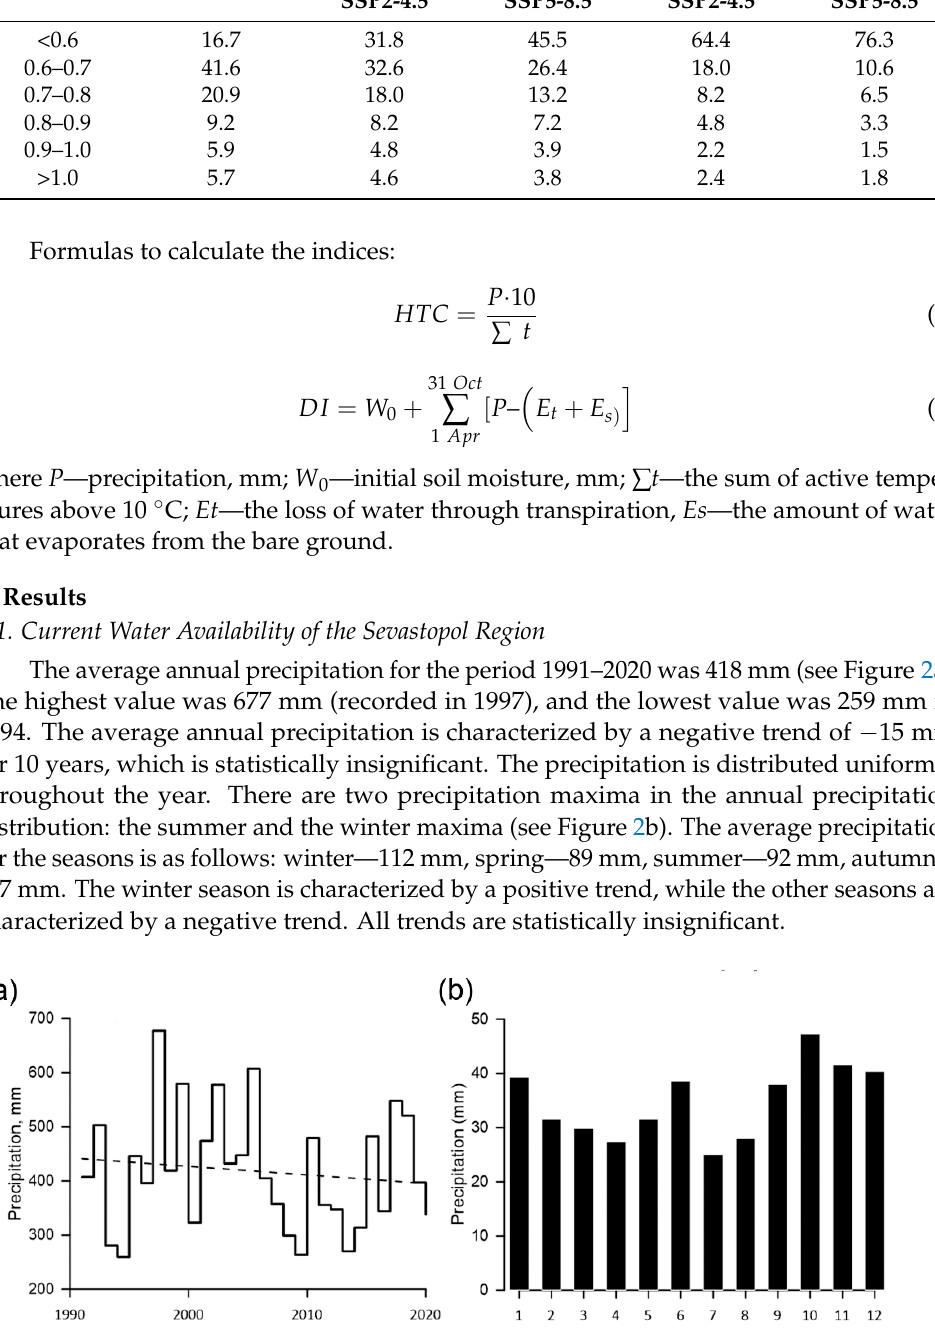
Figure 2. Long-term variation of annual precipitation. The dashed line represents a linear trend ( a ). Intra-annual distribution of precipitation ( b ) in Sevastopol between 1991 and 2020.